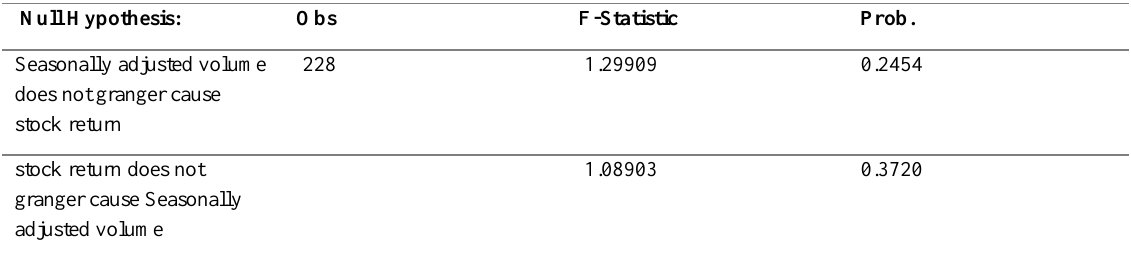
Table 11: Panel Granger causality for Small Finance